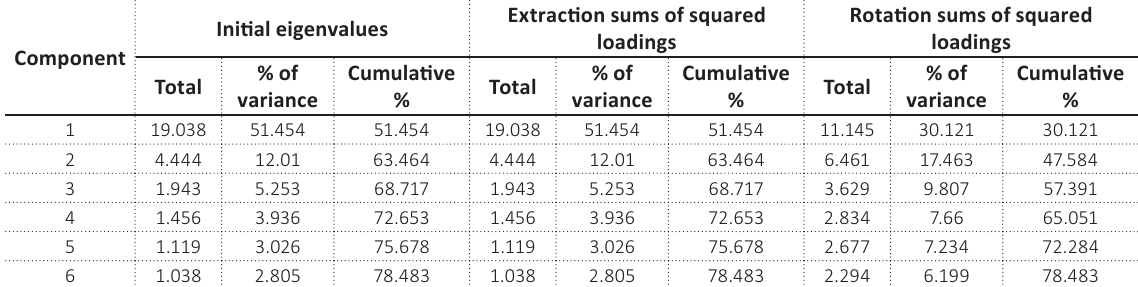
Table 3. Total variance